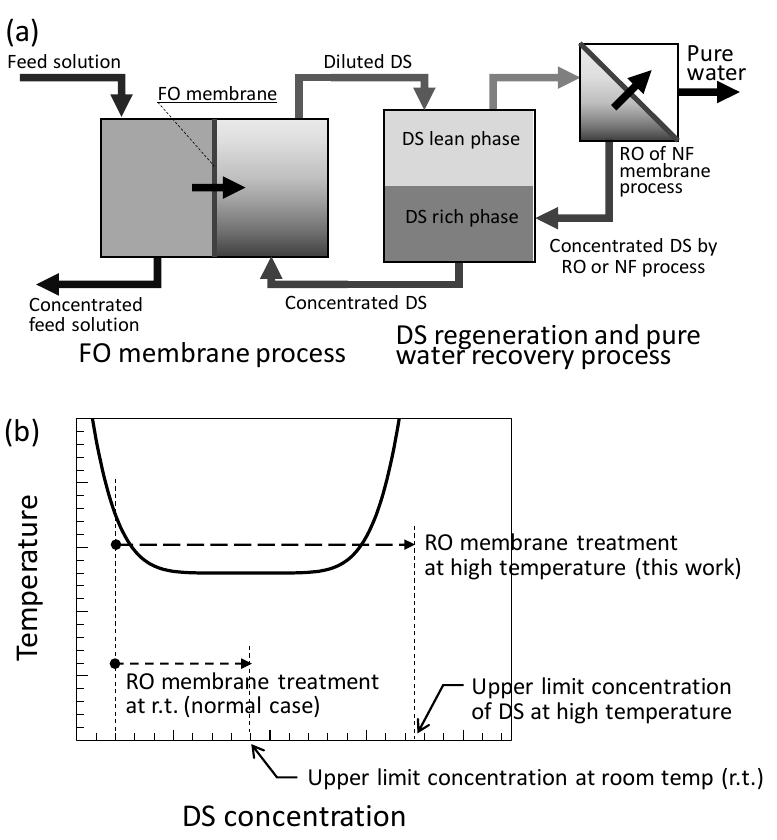
Figure 1. ( a ) Schematic of the FO process involving DS regeneration and pure water recovery processes with an RO or NF membrane. ( b ) Schematic DS concentration change by RO membrane treatment.